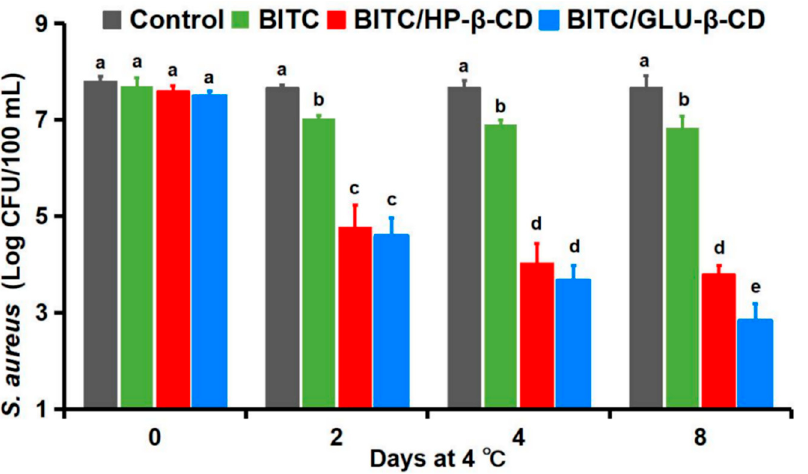
Figure 4. Antimicrobial activity of free and encapsulated BITC against S. aureus inoculated after pasteurization (63 ◦ C, 30 min) of broccoli juice stored at 4 ◦ C. Different letters among bars indicate significant differences among BITC treatments during storage time ( p < 0.05).